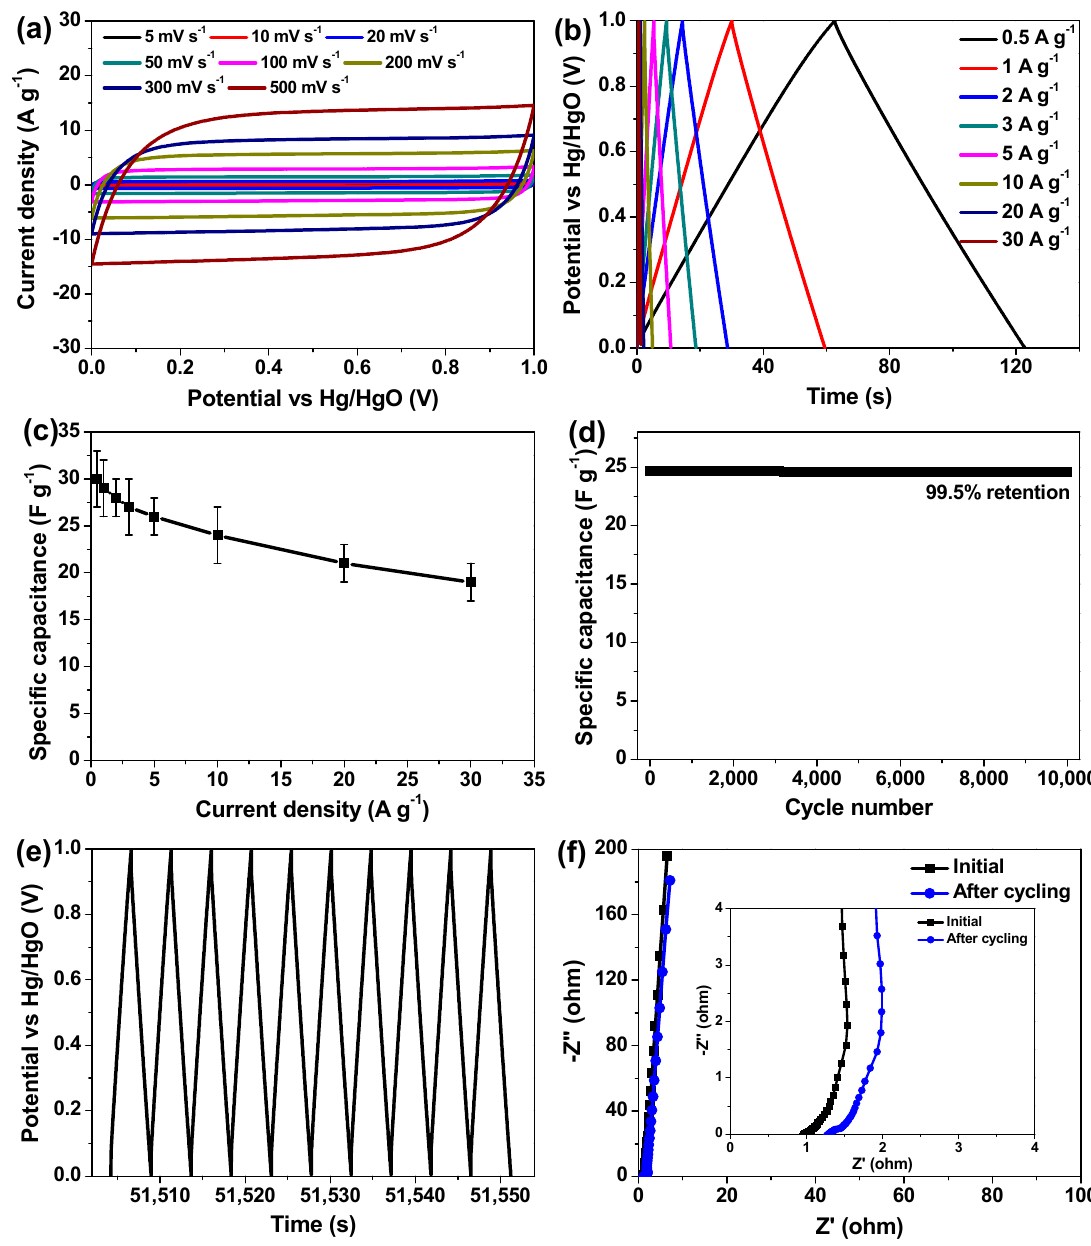
Figure 7. Supercapacitive behaviors of single symmetric supercapacitor cell of HPC-2//HPC-2. ( a ) Its CV curves measured at a set of sweep rates; ( b ) its GCD curves obtained at a series of current densities; ( c ) its specific capacitance as a function of current density; ( d ) its cyclic performance for repetitive charge/discharge at a high current density of 10 A g − 1 for over 10,000 cycles; ( e ) its last 10-cycle charge/discharge curve of such cycling stability test; and ( f ) its initial Nyquist plot (black curve) and the one after such cycling stability test (blue curve); the inset is the zoom view of the Nyquist plots for high frequencies.